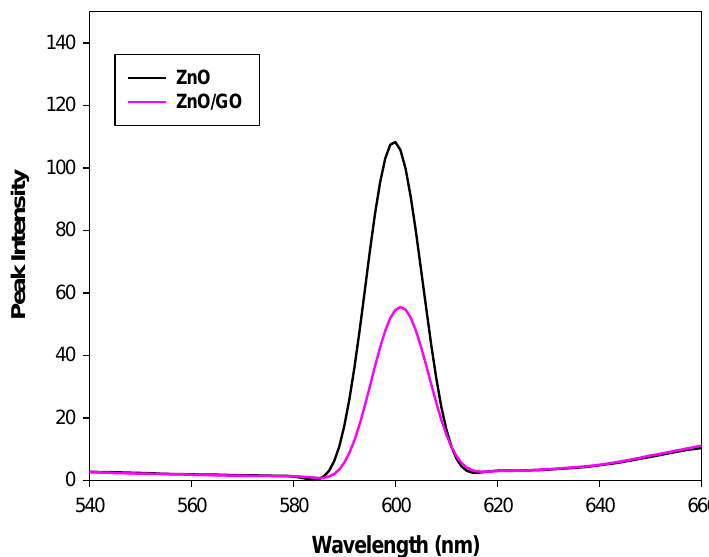
Figure 6. PL spectra of ZnO and ZnO/GO.